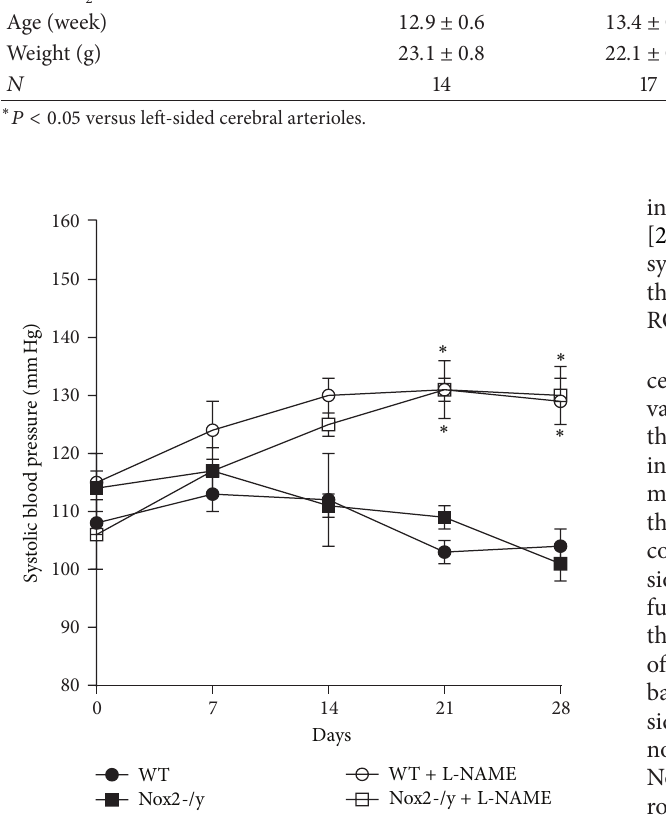
Figure 2: Graph showing systolic blood pressures measured by tail- cuffmethod.Resultsweretheaveragesofthirtymeasurementsmade on days 0, 7, 14, and 28 of 6 individual mice. ∗ 𝑃 < 0.05 versus corresponding control treatment